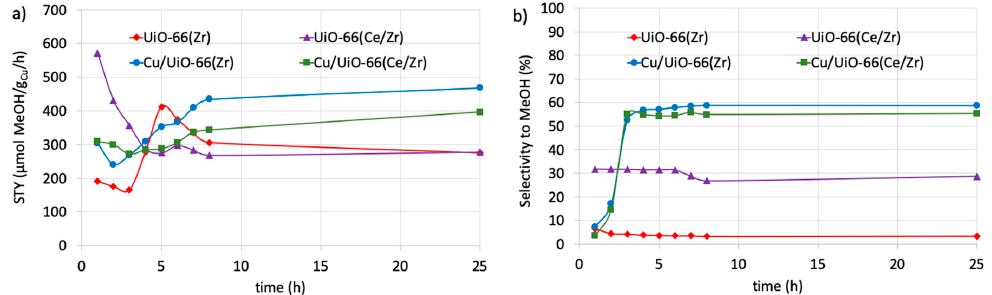
Figure 9. Space time yield ( a ) and MeOH selectivity ( b ) during catalytic tests of CO 2 hydrogenation